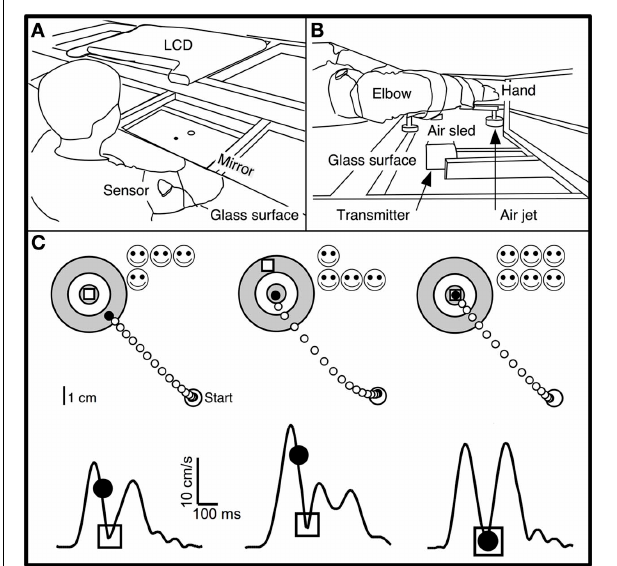
FIGURE 1 | Experimental apparatus and skill task. (A,B) Subjects were seated at a table with their dominant arm strapped to a support (air sled) that was lifted slightly off the table by compressed air jets, which allowed frictionless planar arm motion. They viewed the display of an LCD screen, reflected by a mirror located above their arm. The middle finger’s tip position was displayed as a cursor (black circle) whose virtual image in the mirror coincided with the fingertip’s physical location. Magnetic sensors on the upper arm and forearm recorded position of fingertip, elbow, and shoulder. (C) Spatial (upper panels) and temporal (lower panels) illustration of the double-marker task. The subject’s hand moved from the start circle toward the target. The handpath (white circles) was not visible to the subject. After 200ms, a “timed disc” (black circle) appeared at the middle fingertip’s location at that time. An “endpoint square” (white square) appeared at the location where the hand reversed direction and returned toward the start circle. Subjects were instructed to place both markers into the center of the target. Faster movements caused the timed disc to be placed closer to the target. This method translated speed into spatial performance with the same metrics as endpoint accuracy. The timed disc’s distance from the target indicated a “speed error,” while the endpoint square’s distance indicated endpoint error. The sum of these errors was a measure of “skill error.” The tangential velocity profiles (hand velocity vs. time) in the lower panels show the timing of these events during single movements, with the timed disc appearing after 200ms and the endpoint square appearing at the time of the first velocity minimum. Left : Sample trial with small endpoint error and large speed error. Middle : Large spatial error and small speed error. Right : Small spatial and speed errors; timed disc and endpoint square both landed within the target